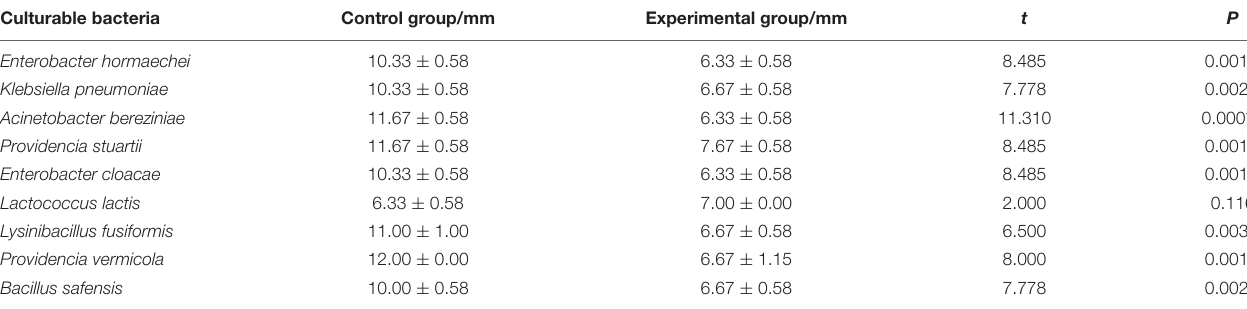
TABLE 3 | Bacteriostatic effect of P. aeruginosa and other cultivable bacteria in the housefly larval intestine. Culturable bacteria Control